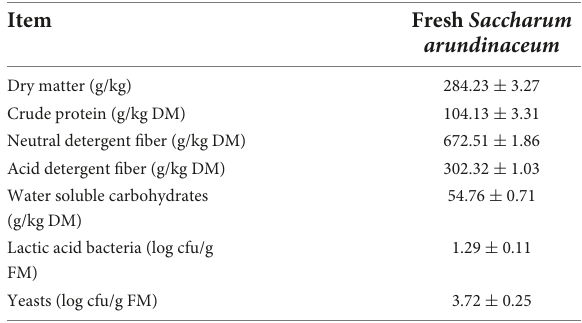
TABLE 1 Microbial and chemical characterization of unfermented Saccharum arundinaceum (mean ± SEM, n =